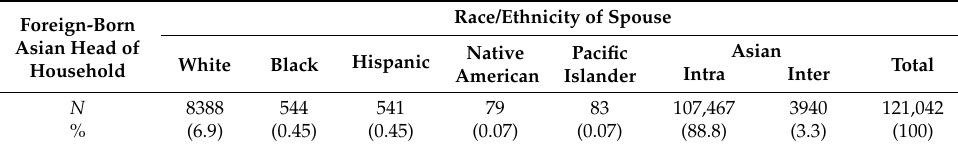
Table 1. Intermarriage Patterns of Foreign-Born Asian Household Heads by Race or Ethnicity of Spouses, ACS 2008–2012.